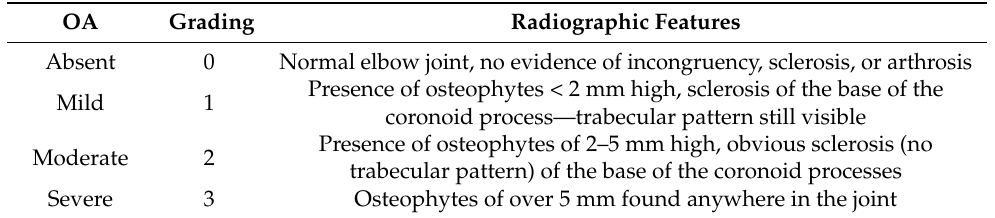
Table 4. International Elbow Working Group (IEWG) guidelines for elbow osteoarthritis.